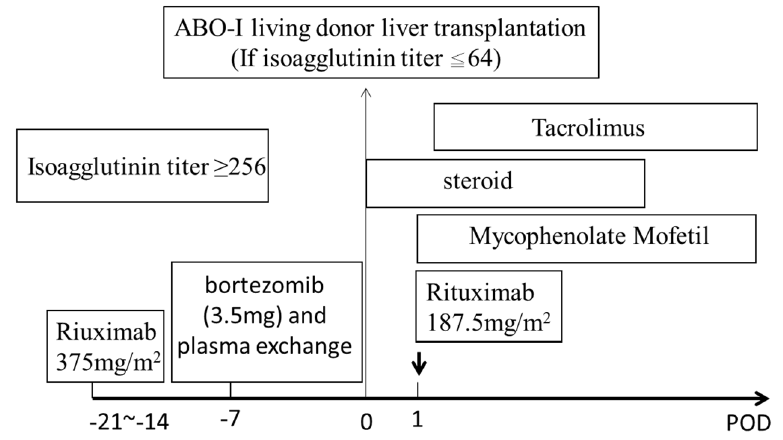
Figure 1. Modified desensitization regimen for preparing ABO-I living donor liver transplantation. If isoagglutinin titers were ≥ 256, desensitization was prepared by intravenously rituximab (375 mg/m 2 ) two to three weeks before liver transplantation, bortezomib (1.3 mg/m 2 ) to deplete plasma cells, and several courses of plasma exchange at one week before transplantation .